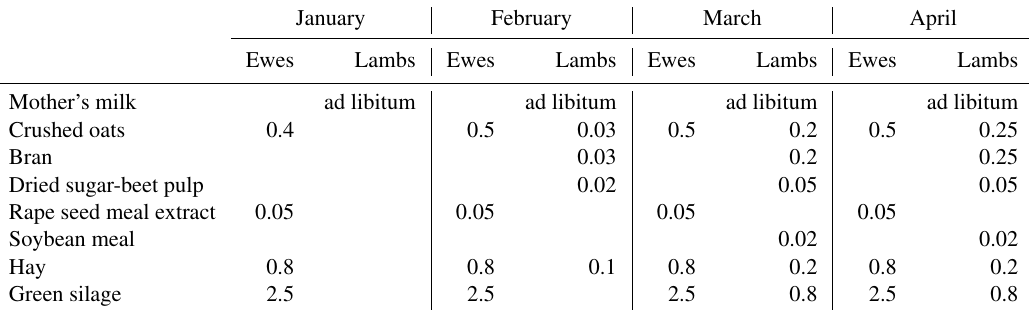
Table 1. Approximate feed ration used for ewes and offspring (kg).